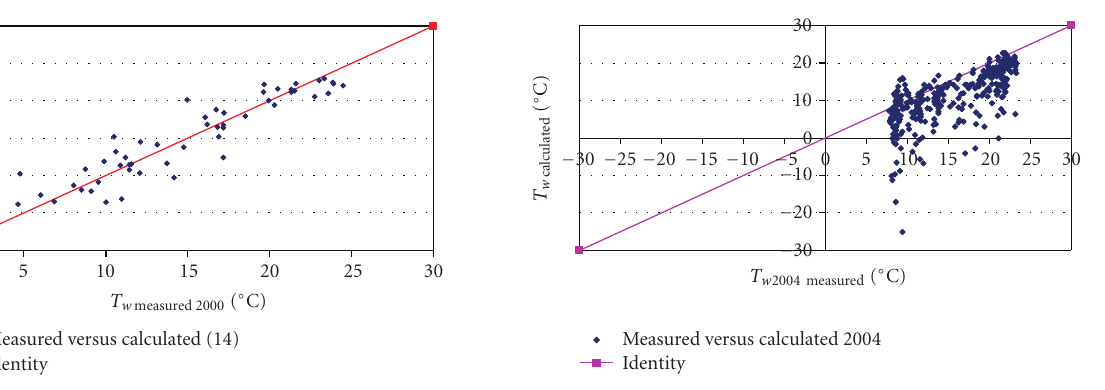
Figure 14: Comparison between measured and estimated data (14), correlation coe ffi cient r Tw , Tw 1 = 0 . 9241.